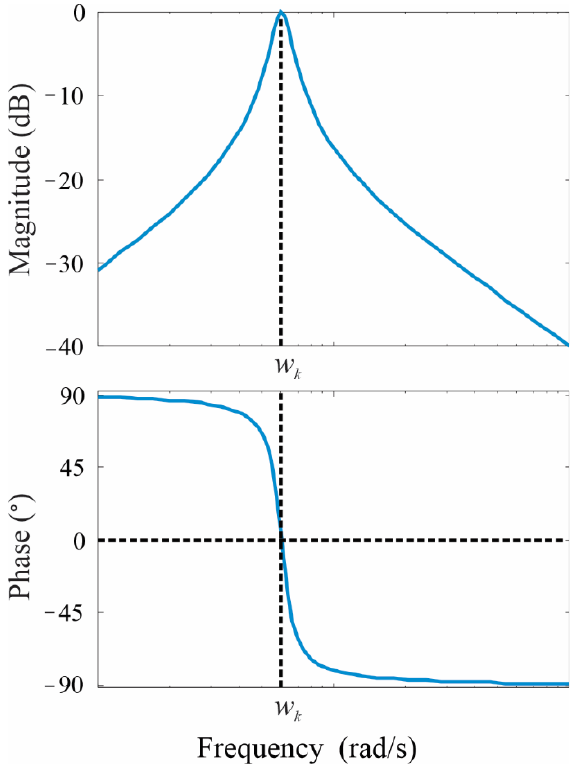
Figure 2. Filter response of the band-pass Filter. The selected BP filter is digitalized by means of the bilinear transform [35]. The digital version of the transfer function is shown in Equation (10).